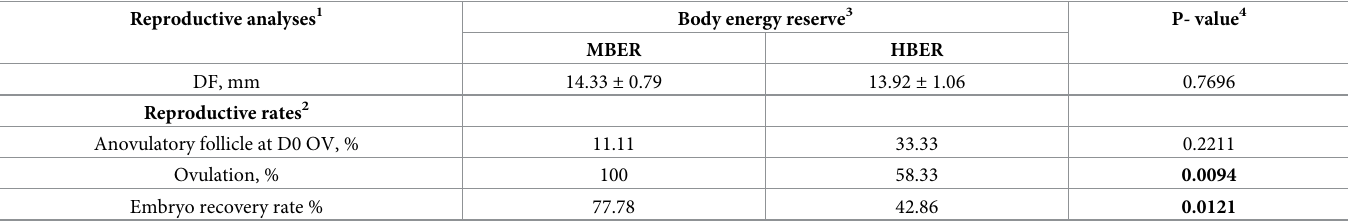
Table 2. Least squares mean, standard error of mean and probability of response to the estrus synchronization protocol and reproductive rates of cows with differ- ent body energy reserve. Reproductive analyses